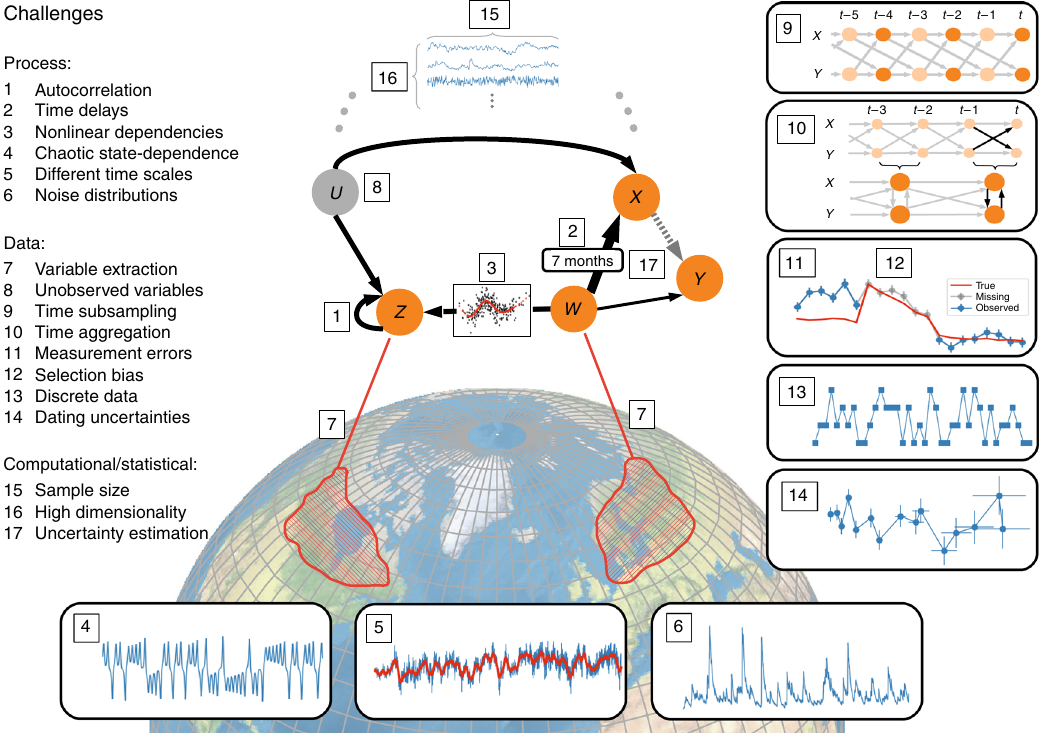
Fig. 4 Methodological challenges for causal discovery in complex spatio-temporal systems such as the Earth system. At the process level, autocorrelation (1), time delays (2), and nonlinearity (3), also in the form of state-dependence and synergistic behavior (4), require a careful selection of the